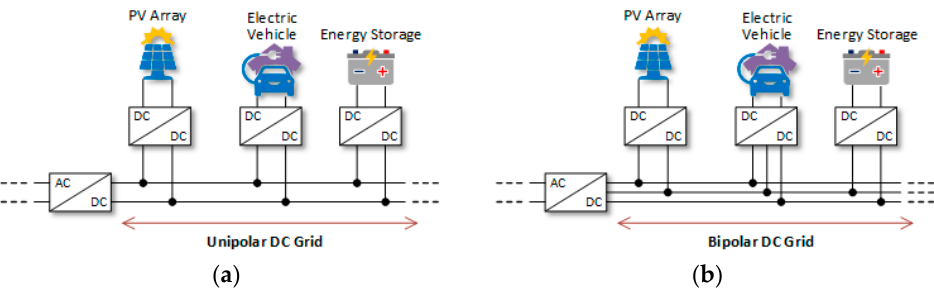
Figure 5. DC-bus configurations: ( a ) unipolar DC-bus; ( b ) bipolar DC-bus.